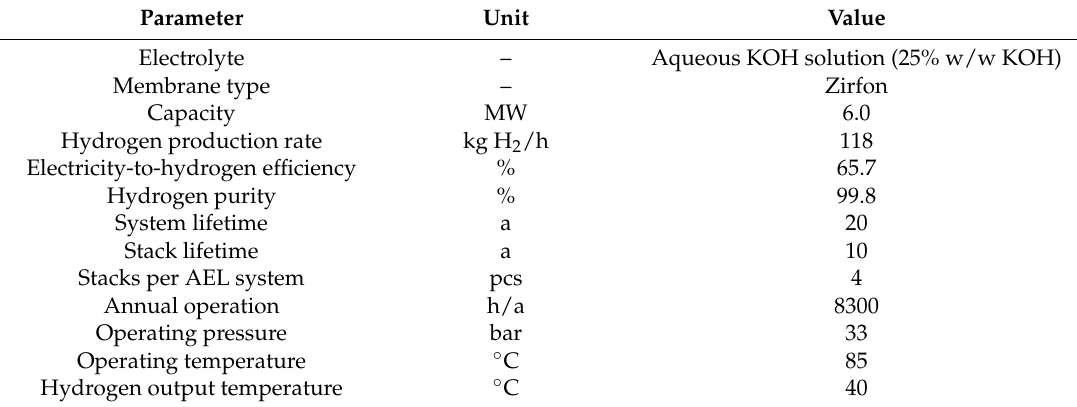
Table 1 points out main characteristics of the assessed AEL technology. Table 1. Alkaline electrolysis technical characteristics (based on Table 1. Alkaline electrolysis technical characteristics (based on [12]).